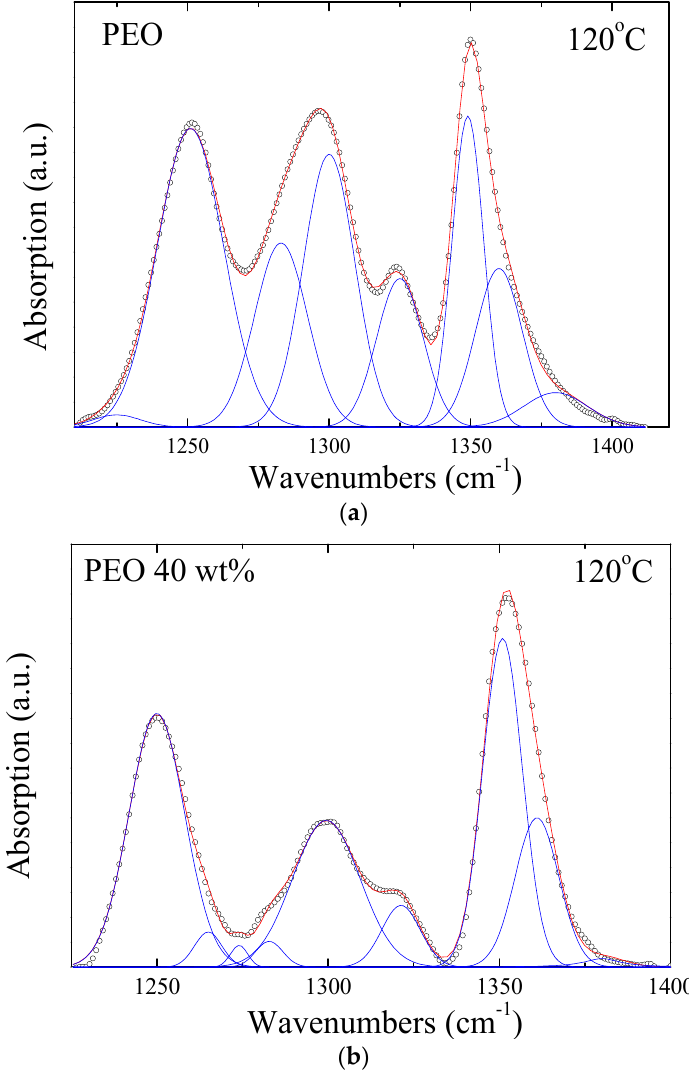
Figure 4. Fitting of ATR-FTIR Spectra of ( a ) pure PEO and ( b ) PEO/Na + -MMT with 40 wt % in PEO at 120 °C. The lines denote the individual Gaussian peaks as well as the total fit.